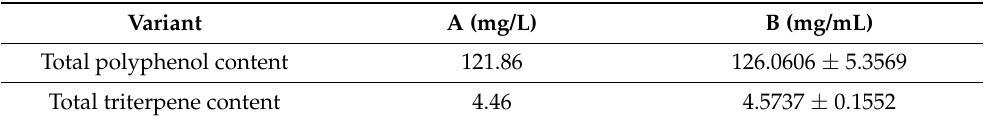
Table 2. Expected (A) and real (B) values of the content of polyphenols and triterpenes from extracts